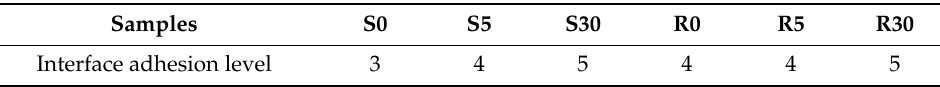
Table 3. Test of bonding performance of sample interface with different number.